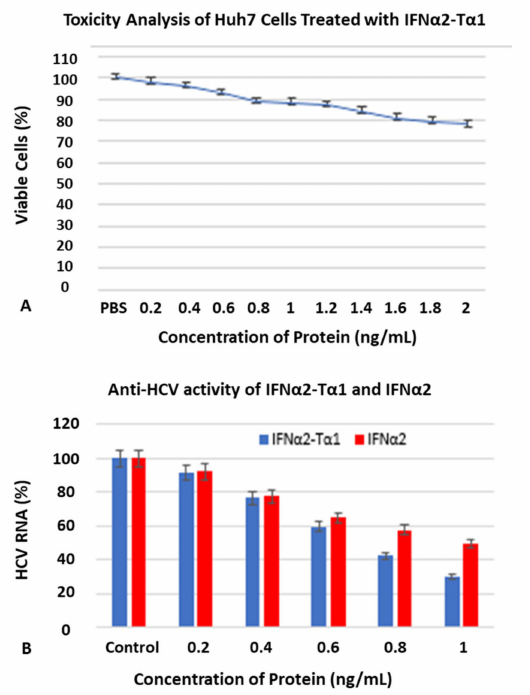
Figure 5. ( A ) Toxicity analysis of IFN α 2–T α 1 by trypan blue exclusion test on Huh7 cells. IFN α 2–T α 1 up to concentration of 2 ng/mL at which ~85% cells are viable was considered as non-toxic for cells. ( B ) IFN α 2–T α 1 analyzed for anti-HCV activity in comparison with IFN α 2. IFN α 2–T α 1 showed higher anti-HCV activity (70.40%) in HCV-infected Huh7 cells as compared to IFN α 2 (51.39%) at similar concentration. Data are represented as Mean ± SD (n = 3, two-way ANOVA, p < 0.05 considered significant with 95%